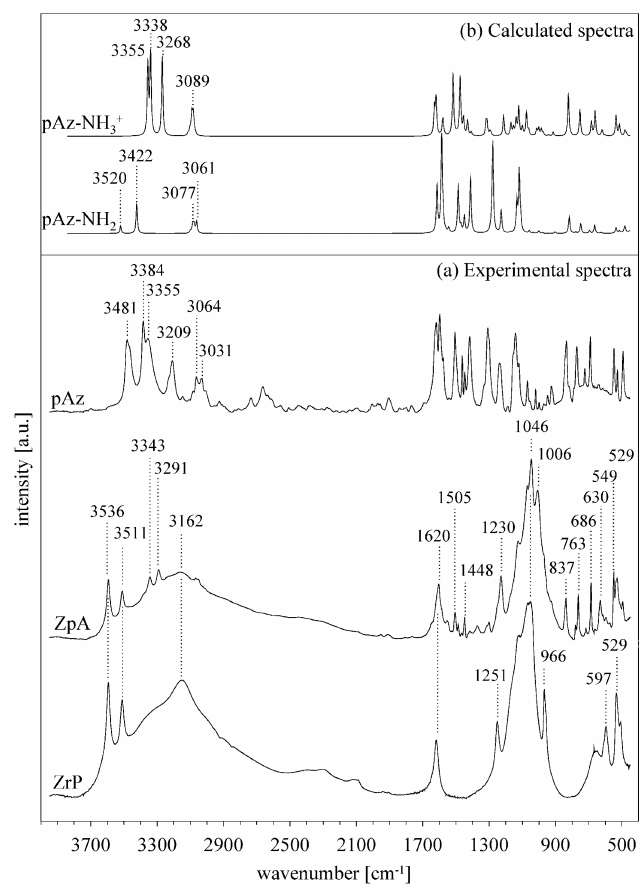
Figure 5. ( a ) The experimental FTIR spectra of ZrP, ZpA, and pAz samples, and ( b ) the calculated spectra of neutral pAz (Az-NH 2 ) and protonated pAz (Az-NH 3 +